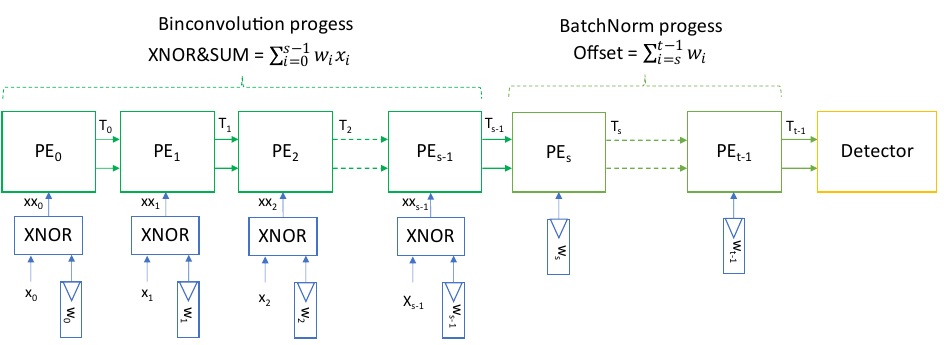
Figure 2. PE array based on time domain. The left part completes the binary convolution process. Here, we use the weight reuse mode, where the weight can be stored in the on-chip register before the calculation starts. After the computing begins, the output feature values of the upper layer are input in order, and XNOR operations are performed with the weights. The delay difference is transmitted from left to right to complete the “multiply–accumulate” function, i.e., XNOR & SUM = ∑ s − 1 w i x i . The middle part is the process of batch normalization, which i = 0 improves the batch normalization operation to avoid the participation of adders and subtractors. The process of batch normalization is described in detail in Section 4.1.2. After several PEs, the delayed signal finally reaches the